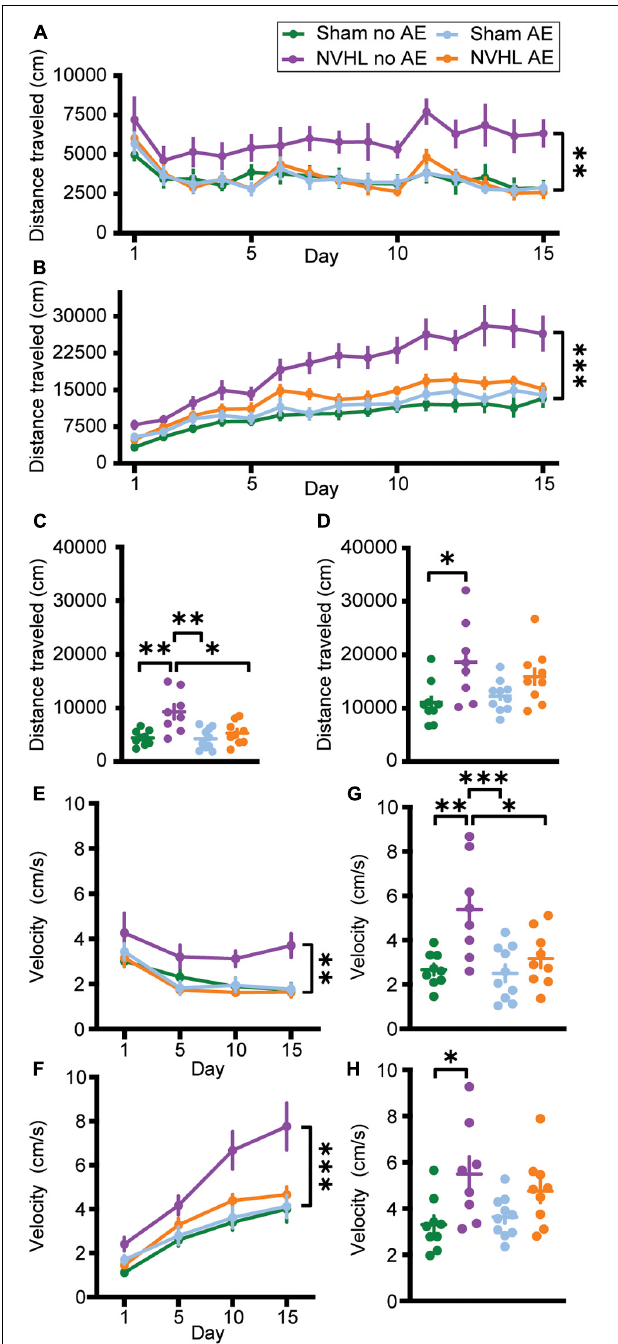
FIGURE 4 | Total distance traveled and average velocity. (A) Total distance traveled before an injection of 0.5 mg/kg nicotine across the 15 sensitization sessions. (B) Total distance traveled after an injection of 0.5 mg/kg nicotine across the 15 sensitization sessions. The NVHL no AE group showed significantly greater distance traveled compared to the Sham no AE, NVHL AE, and Sham AE groups during both the preinjection and postinjection phases. (C) On the preinjection phase of the challenge day, the NVHL no AE group showed significantly more distance traveled than the other three groups. (D) During the postinjection phase on the challenge day, the NVHL no